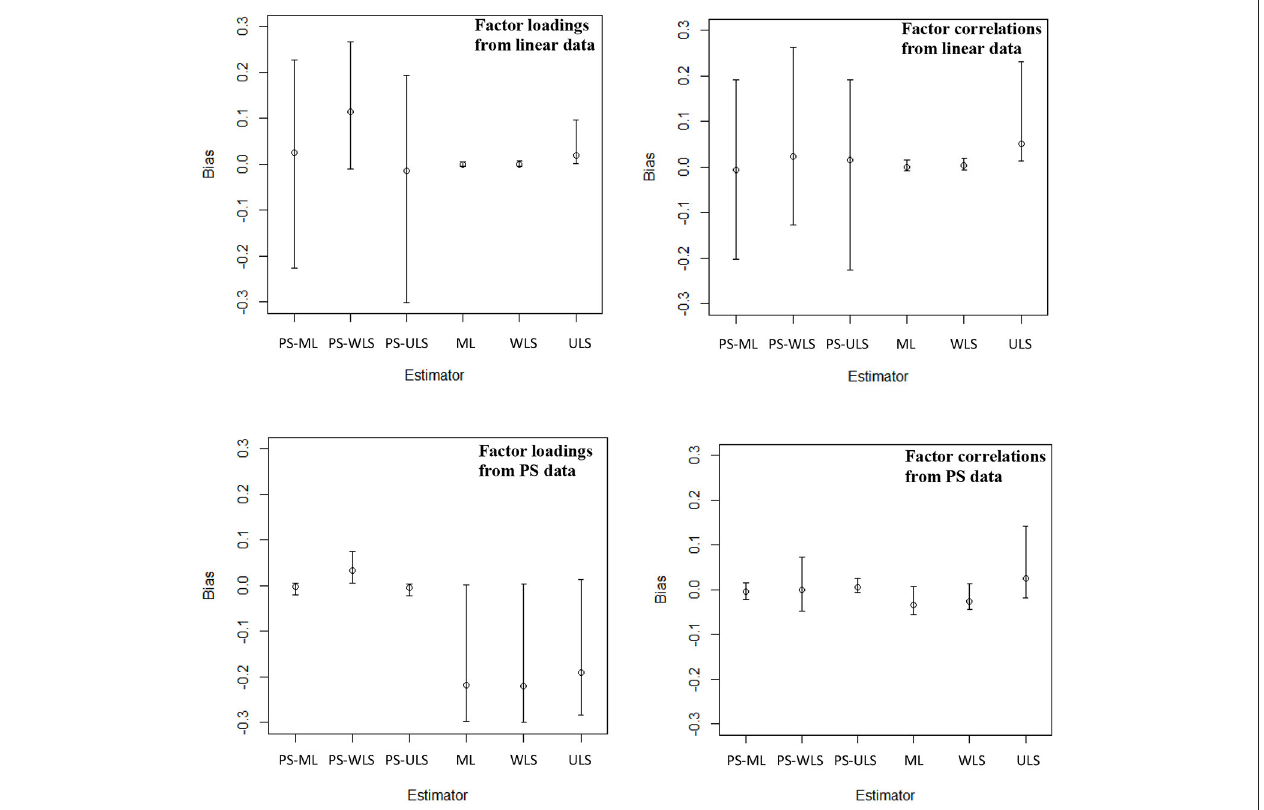
FIGURE 2 | Biases of the factor loadings and factor correlations when data are linear or PS-related. The top left panel shows the mean, min, and max of the biases of 20 factor loadings across 40 conditions, and the top right panel shows the mean, min, and max of the biases of 6 factor correlations across 40 conditions, when data are linear-based. The bottom left panel shows the mean, min, and max of the biases of 20 factor loadings across 40 conditions, and the bottom right panel shows the mean, min, and max of the biases of 6 factor correlations across 40 conditions, when data are PS-based.